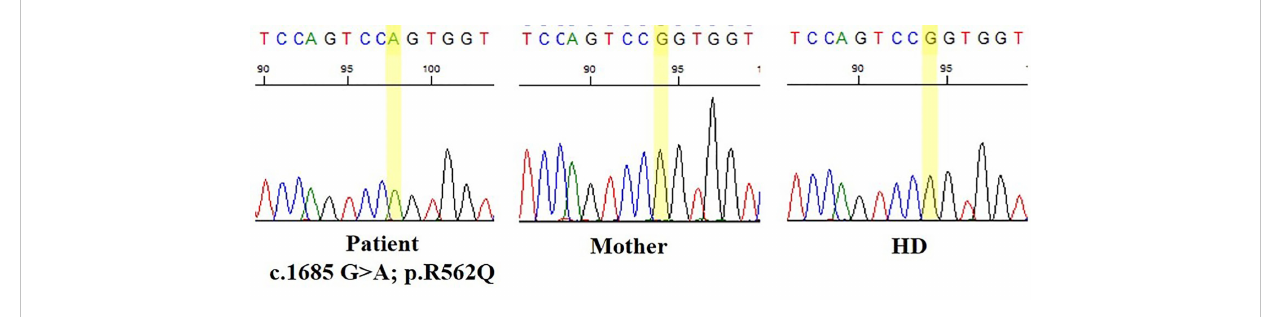
FIGURE 1 Nucleotide substitution (c.1685G>A, p.R562Q) located in the tyrosine kinase domain of Bruton ’ s tyrosine kinase (BTK)